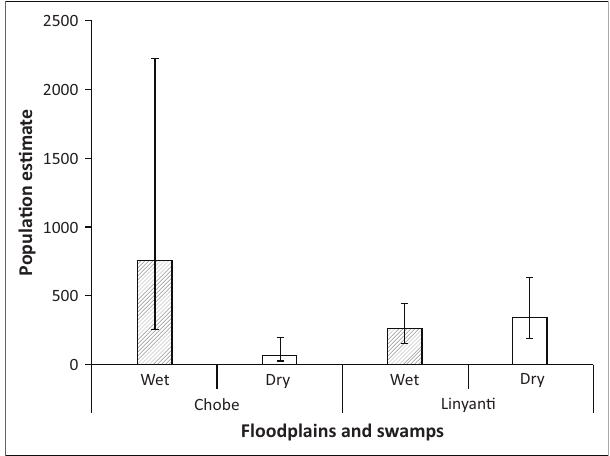
FIGURE 2: Population estimate of red lechwe in the Chobe floodplains and the Linyanti swamps in the wet and dry season. TABLE 1: Population estimate, sex and age ratios of red lechwe ( Kubus leche leche ) in the Chobe floodplains and the Linyanti swamps, and between seasons.